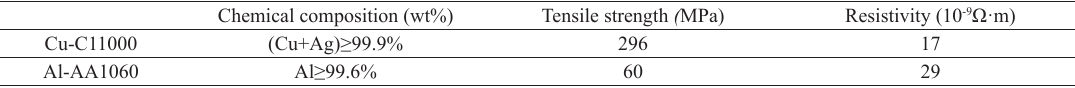
Table 1. Composition and properties of materials used